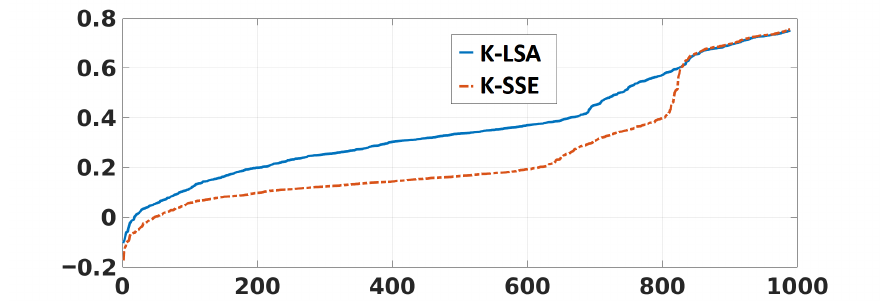
Figure 7. Silhouette index for D 1, weighted via LogTF-Entropy for the